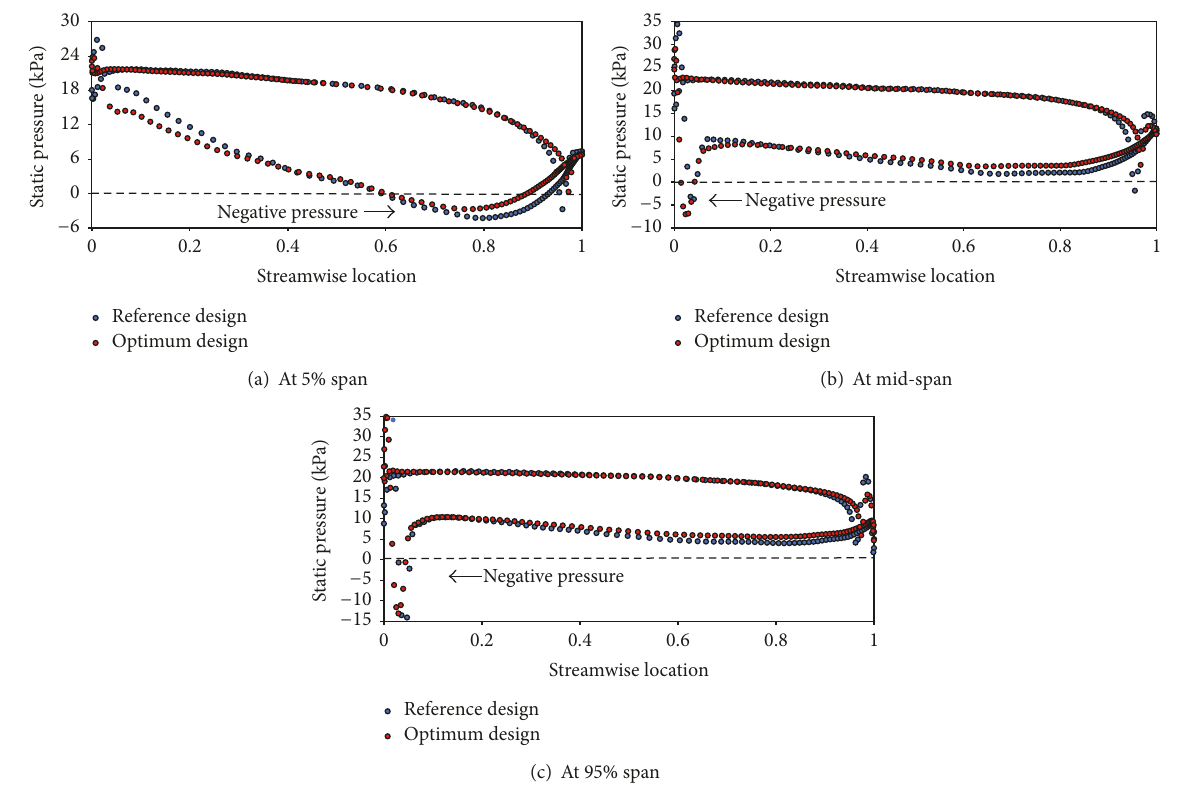
Figure 12: Static-pressure distributions on the blade surfaces of the front runners.